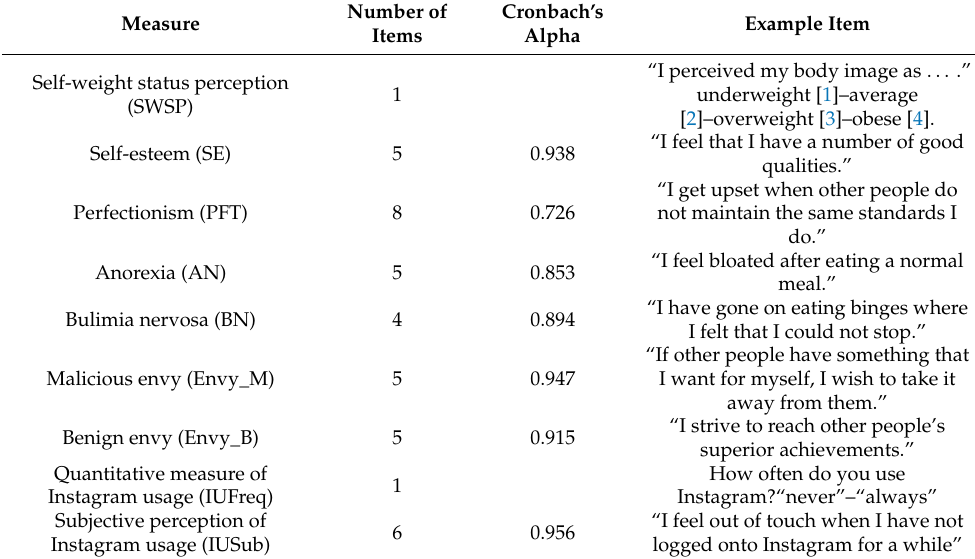
Table 3. Study 2: Number of items, Cronbach’s alpha, and an example item for each measure. Number of Measure Items